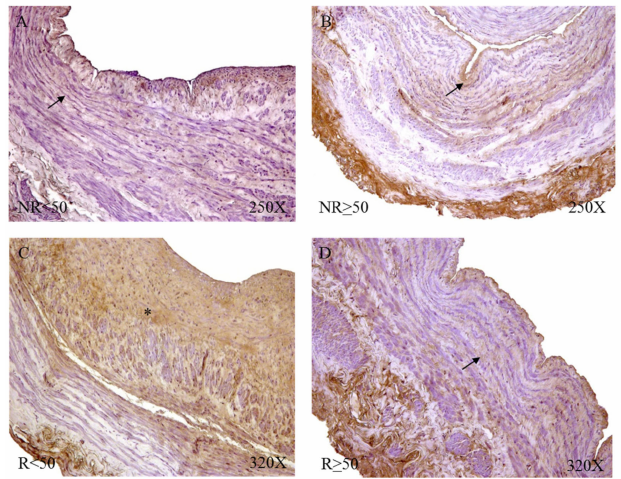
Figure 18. Protein expression of LOXL1 in patients NR < 50 ( A ), NR ≥ 50 ( B ), R < 50 ( C ) and R ≥ 50 ( D